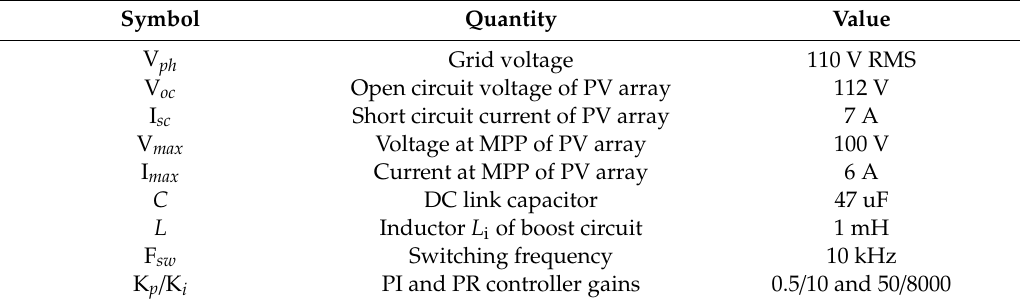
Table 2. Simulation Parameter.